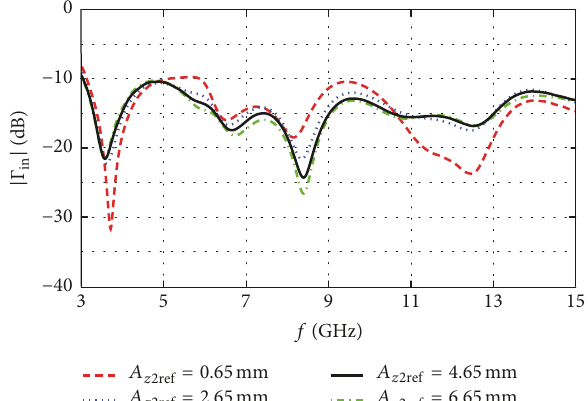
Figure 7: Magnitude of the input reflection coefficient versus frequency for the drop-shaped dipole antenna equipped with a metalreflectorcomputedfordifferentvaluesoftheparameter 𝐴 𝑧2 ref . Structure characteristics: 𝑤 𝑡 = 0.7 mm, 𝑙 𝑡 = 30 mm, 𝐷 = 20 mm, 𝐴 = 20 mm, 𝐴 = 20.5 mm, and 𝐴 = 11.6 mm. 𝑥1 ref 𝑧1 ref 𝑥2 ref